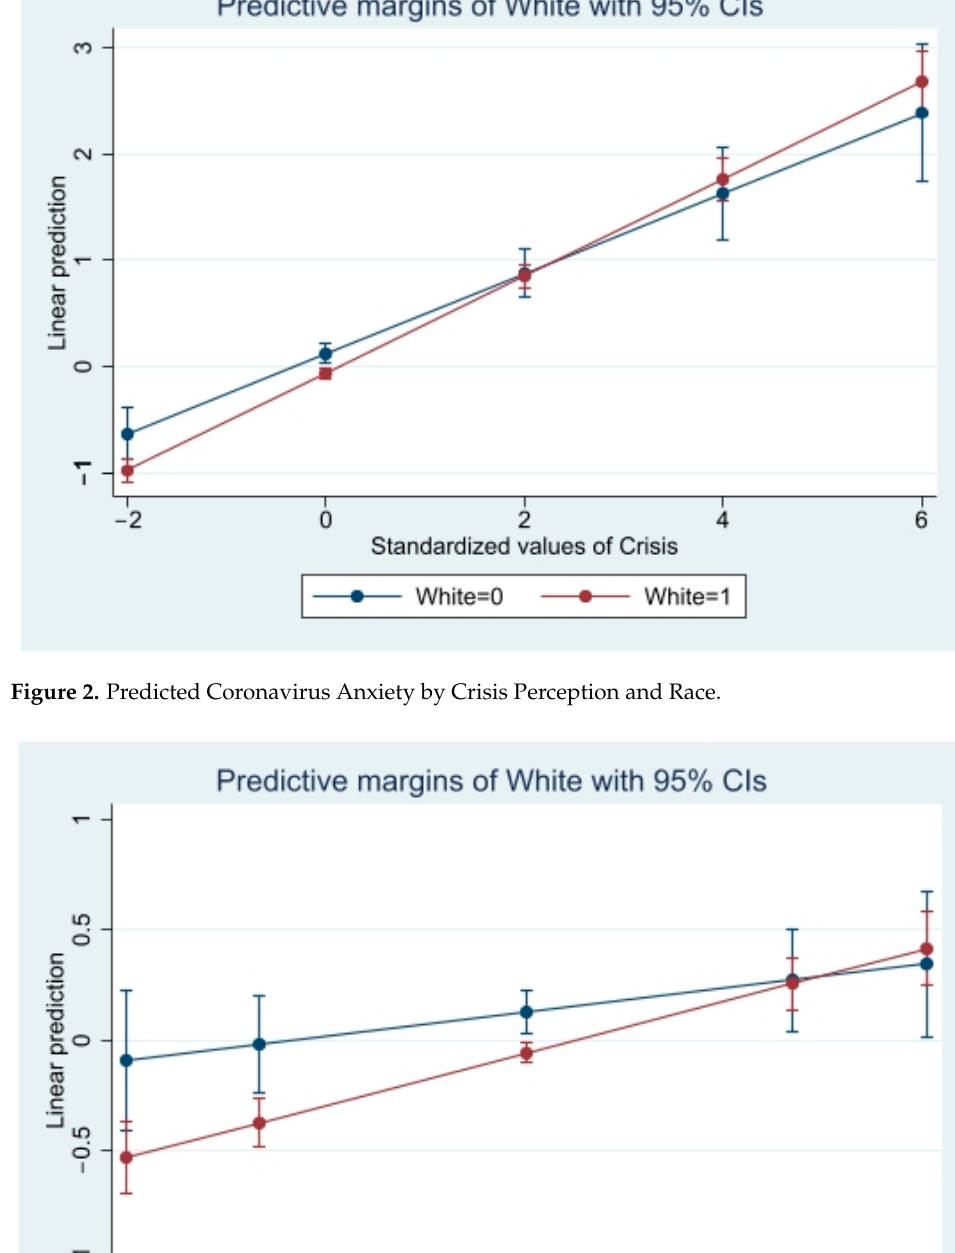
Figure 1. Predicted Coronavirus Anxiety by Crisis Perception and Gender .